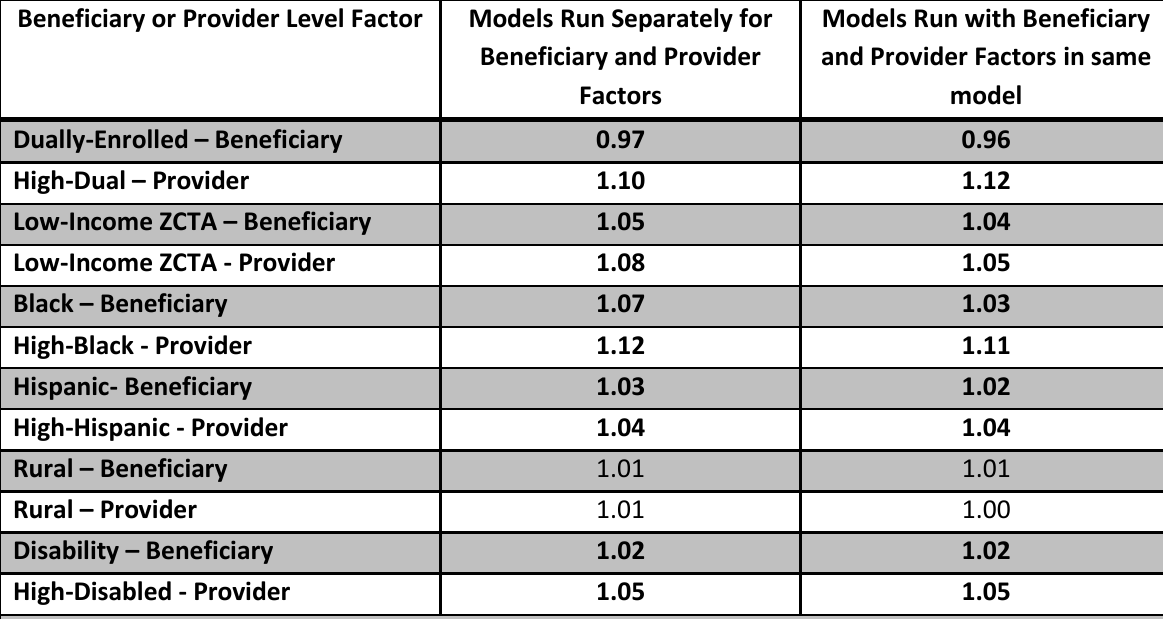
Table 12.6: Beneficiary versus Provider Factors in Readmissions Beneficiary or Provider Level Factor Models Run Separately for